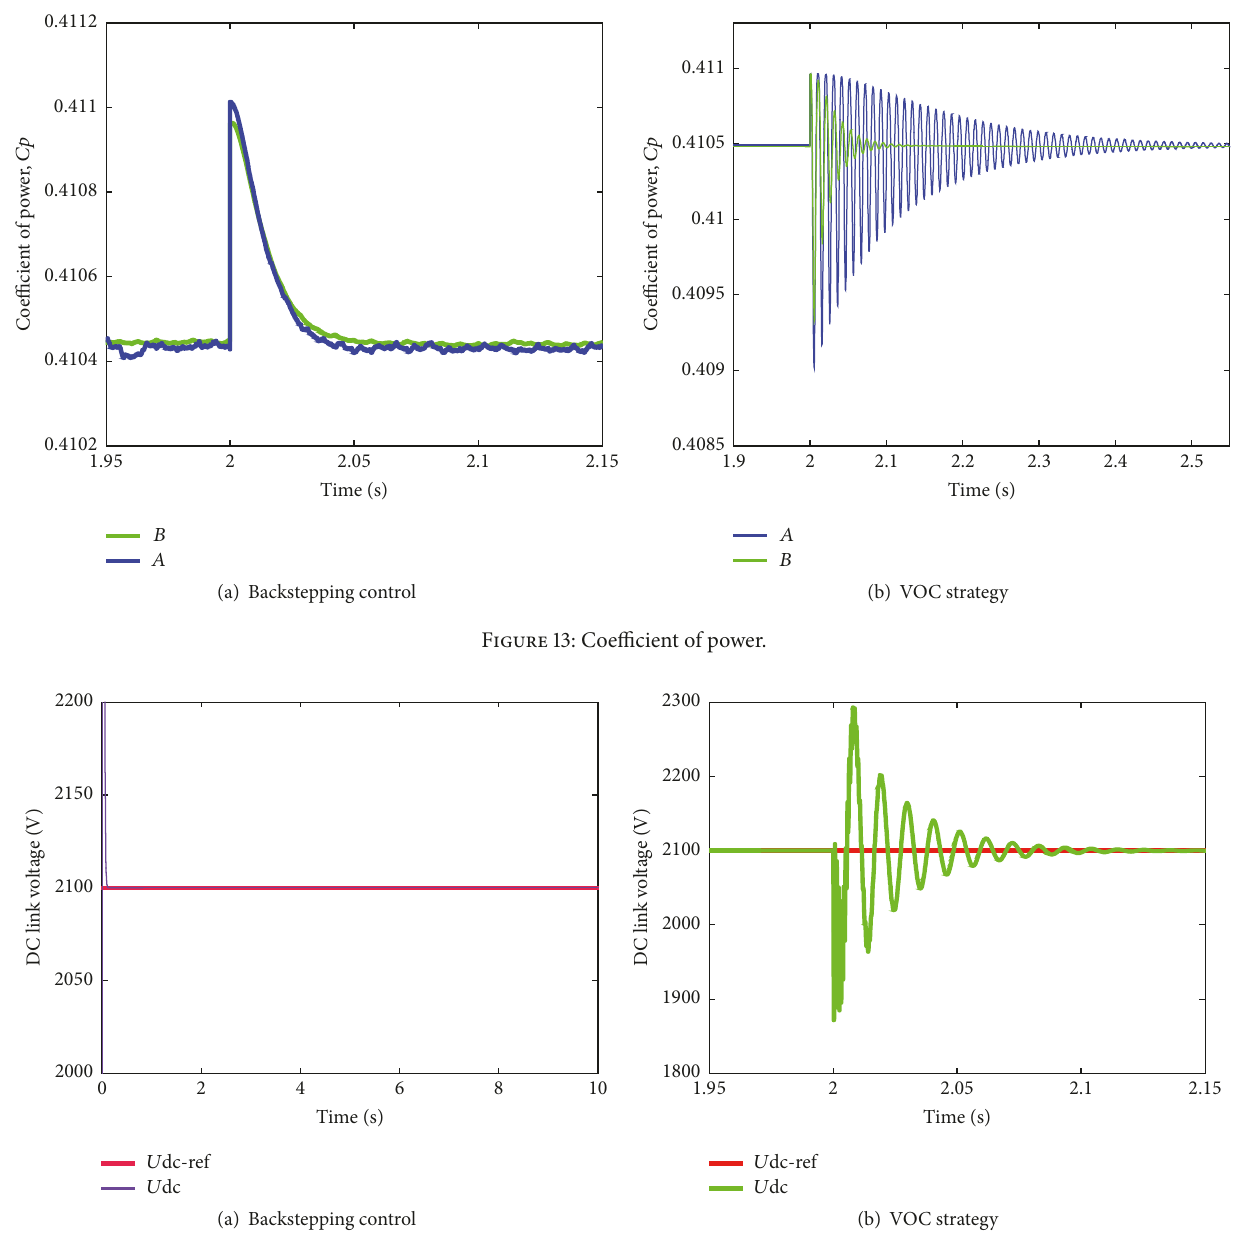
Figure 14: dc-link voltage (V) (with nominal